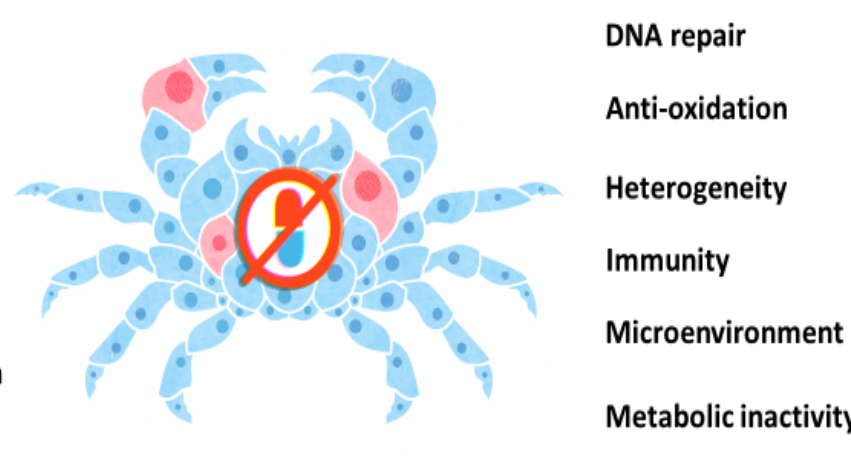
Figure 1. Stem cell origin of drug resistance in cancer. According to Greek mythology, Karkinos (a crab) is the symbol of cancer. Illustration by Benjamin Tu.